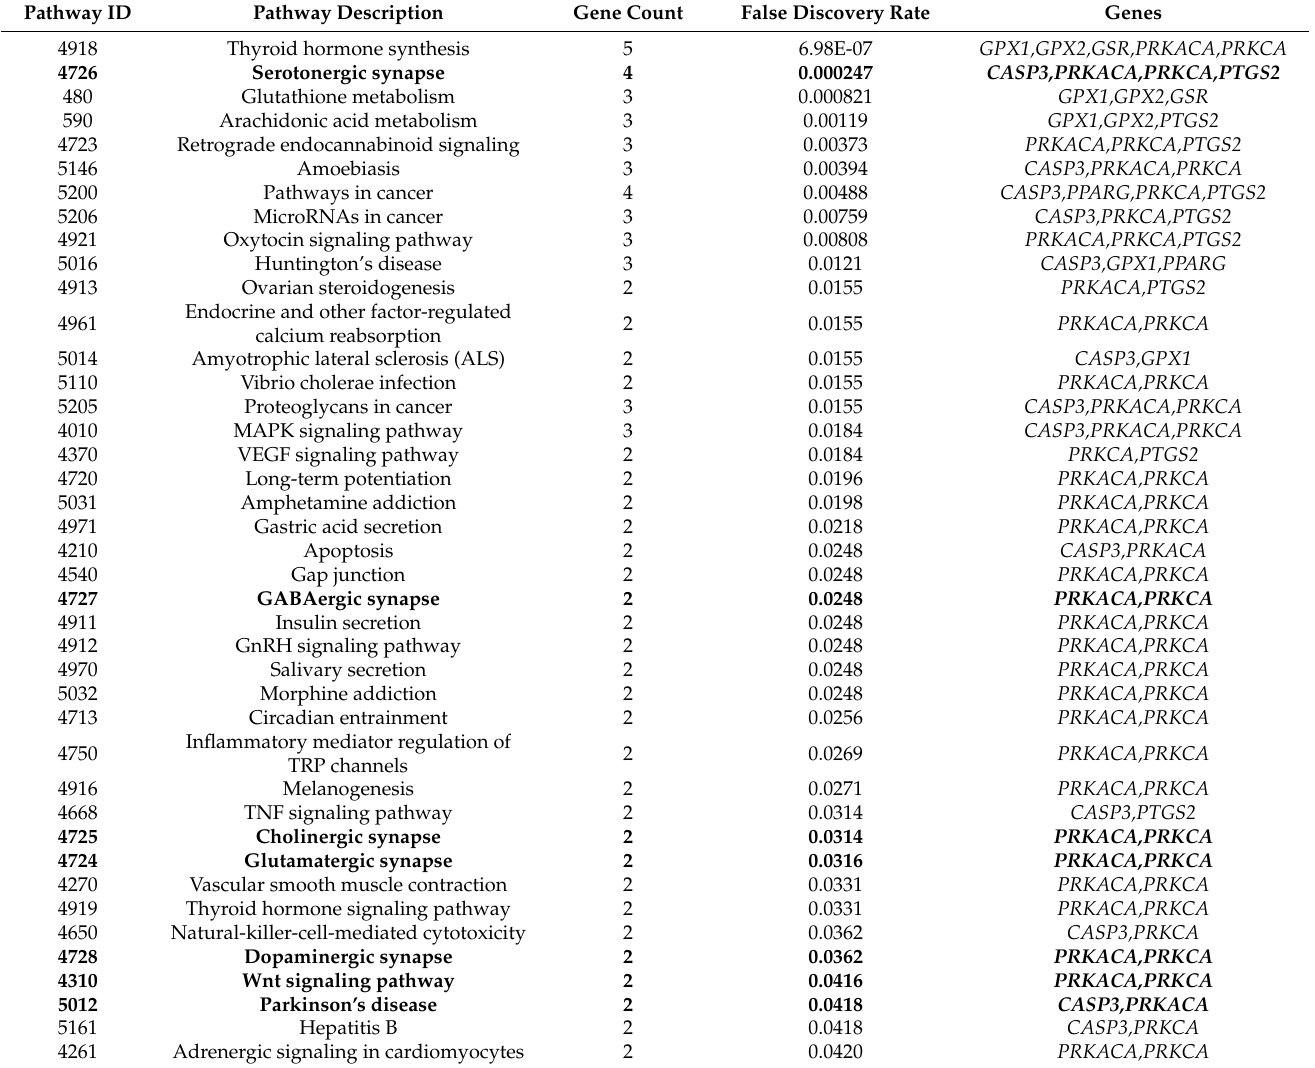
Table 5. Kyoto Encyclopedia of Genes and Genomes (KEGG) analysis of the compounds involved in neuropharmacology. Pathway